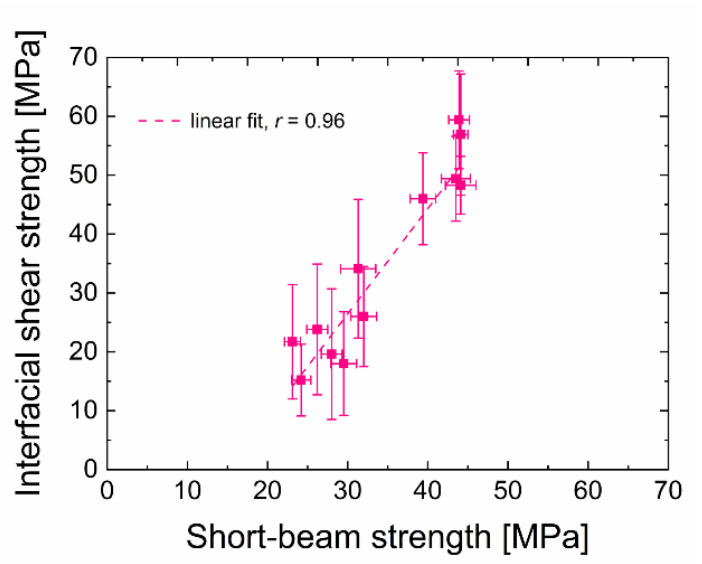
Figure 7. The relationship between IFSS and short-beam strength.